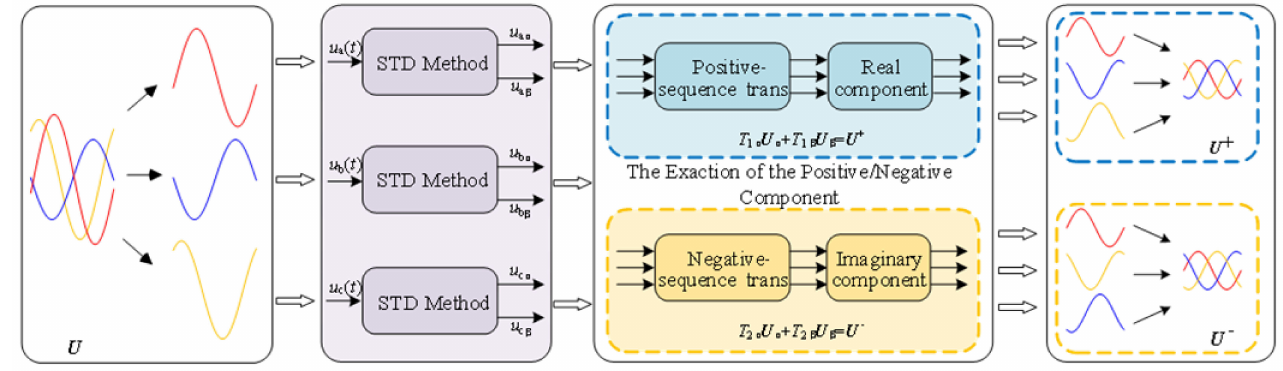
Figure 8. Schematic diagram of extracting positive-sequence and negative-sequence